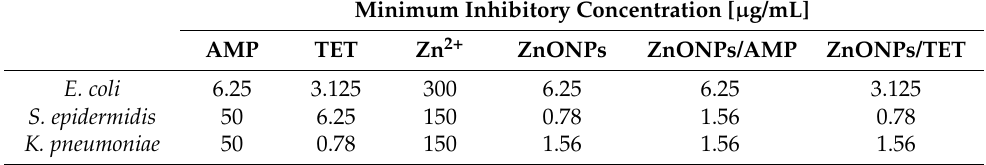
Table 4. The minimum inhibitory concentration (MIC) of ampicillin, tetracycline, zinc ions, zinc oxide nanoparticles immobilized and non-immobilized with